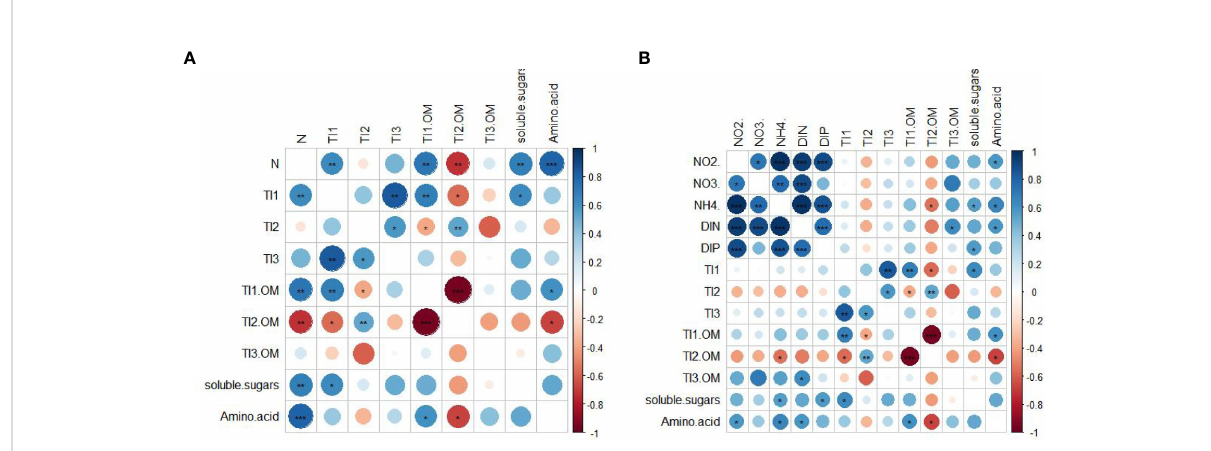
FIGURE 6 Relationship between nitrogen content and thermal organic matter of seagrass (A). Relationship between seawater nutrient concentrations and thermal organic matter of seagrass (B). Blue represents a positive correlation between variables and red represents a negative correlation (* p<0.05 , ** p<0.01 , *** p<0.001